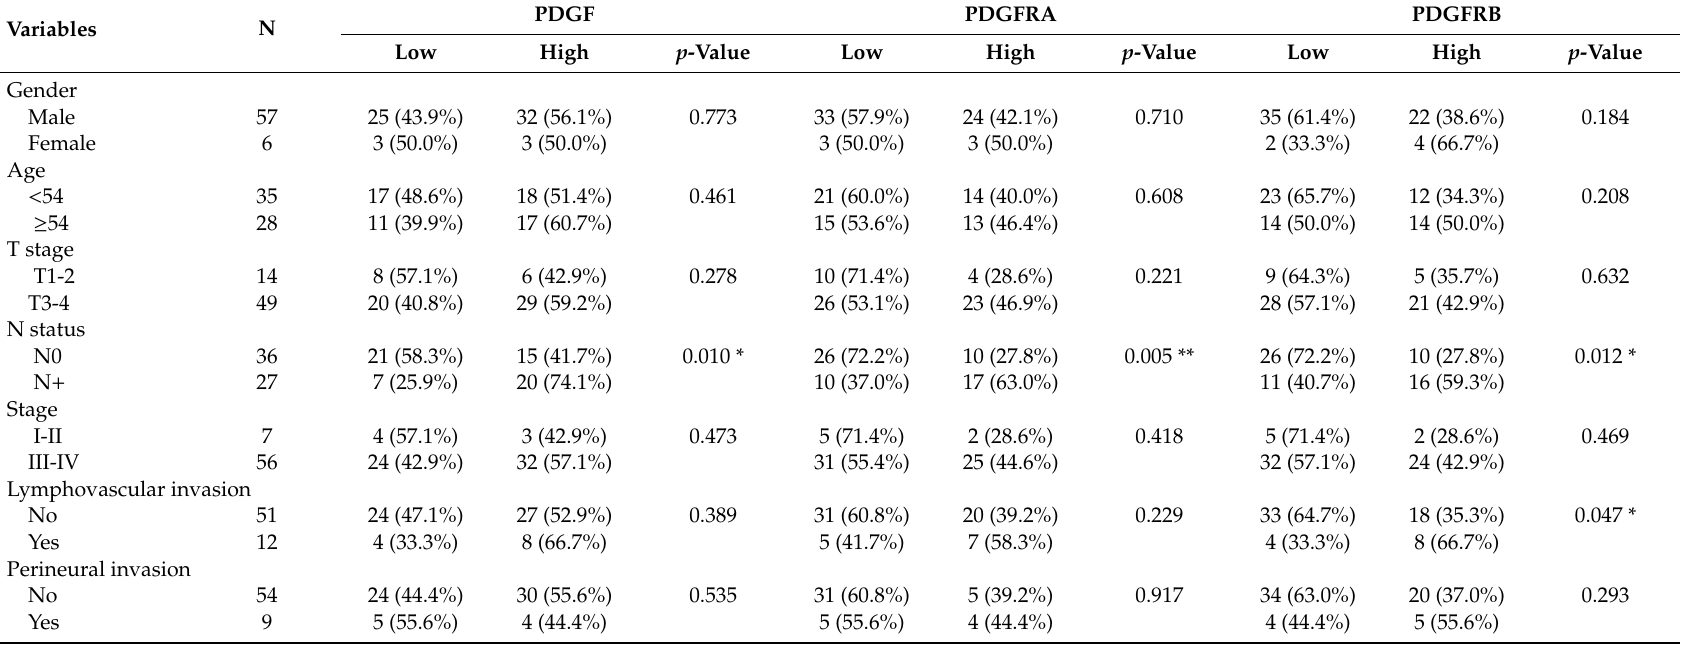
Table 2. Relationship between clinical parameters and immunoexpression of PDGF and PDGFR in OSCC